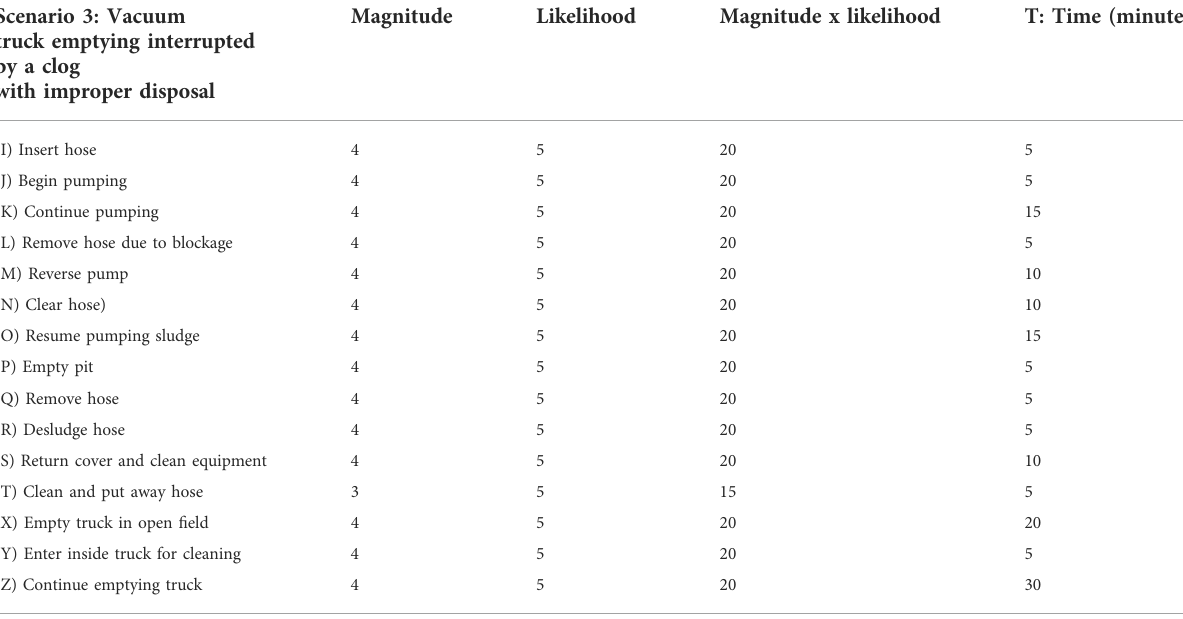
TABLE6Scenario3, Excerptoffecalaerosolinhalationriskscoresforvacuumtruckemptyinginterruptedbyaclogwithimproperdisposal.Operator enters the truck for cleaning. Solid lines between rows denotes to a break in steps. See Supplementary Material for the complete set. Scenario 3: Vacuum truck emptying interrupted by a clog with improper